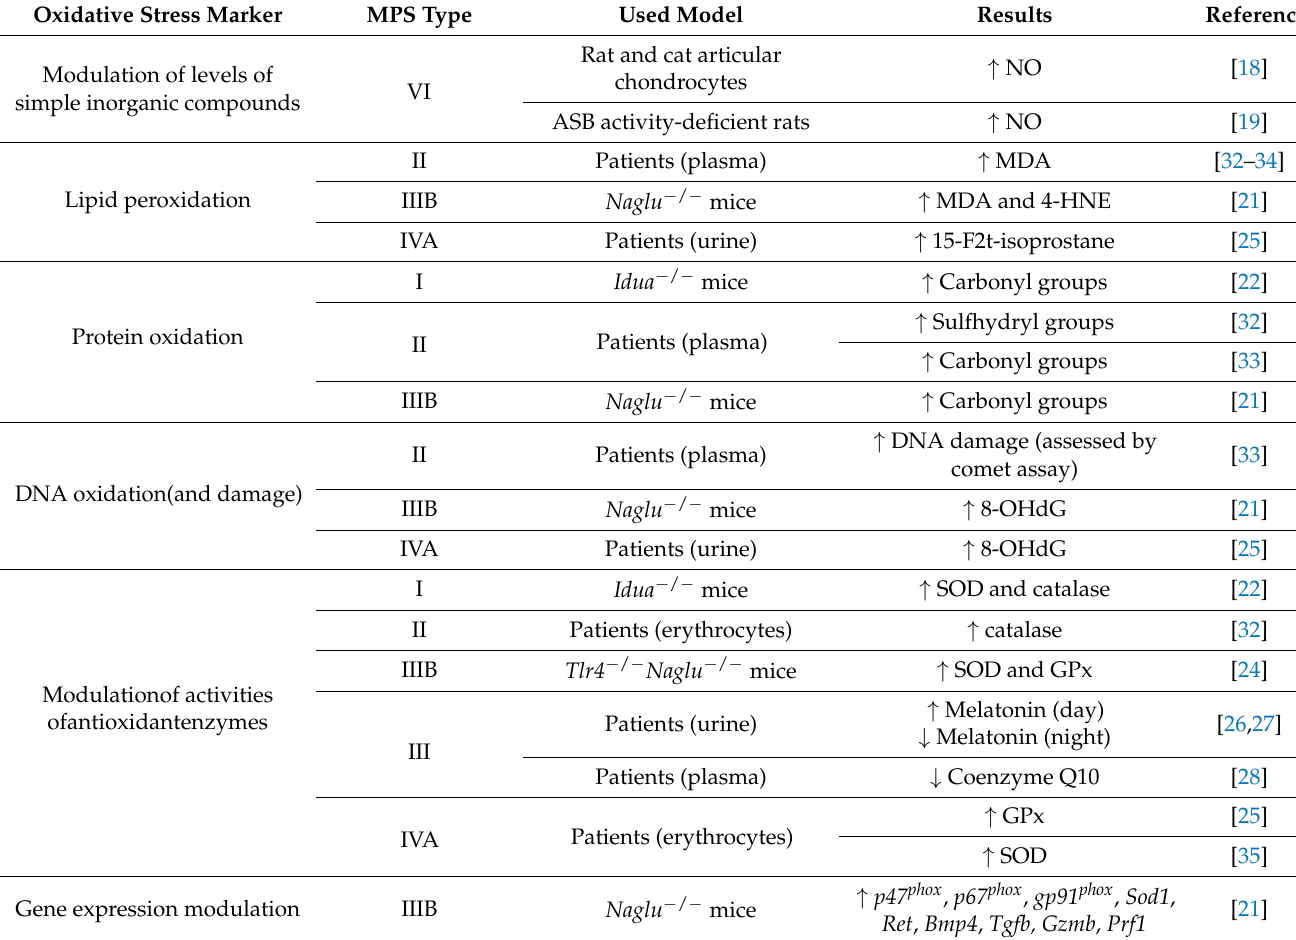
Table 2. Markers of oxidative stress in